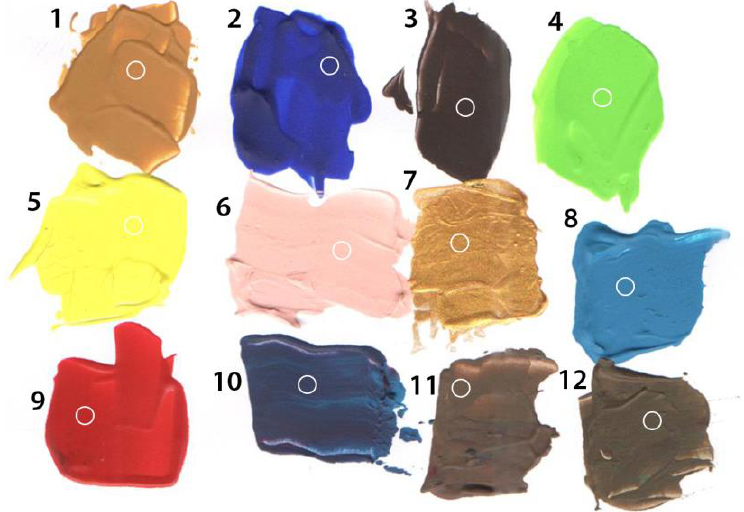
Figure 1. RGB—visible spectrum, 12 acrylic dyes. The individual components of the yellow, magenta, blue (cyan), and black colors are described in [4]. The visible range of the dyes is determined from 360 to 760 nm. As shown in Figure 2, these dyes were photographed with a filter at 735 nm [15]. The yellow and red color components have a range of up to 650 nm; thus, they do not react. As shown in Figure 2, only the blue color component retained the minimum values of the parameters *a and *b, which determine the state of the color